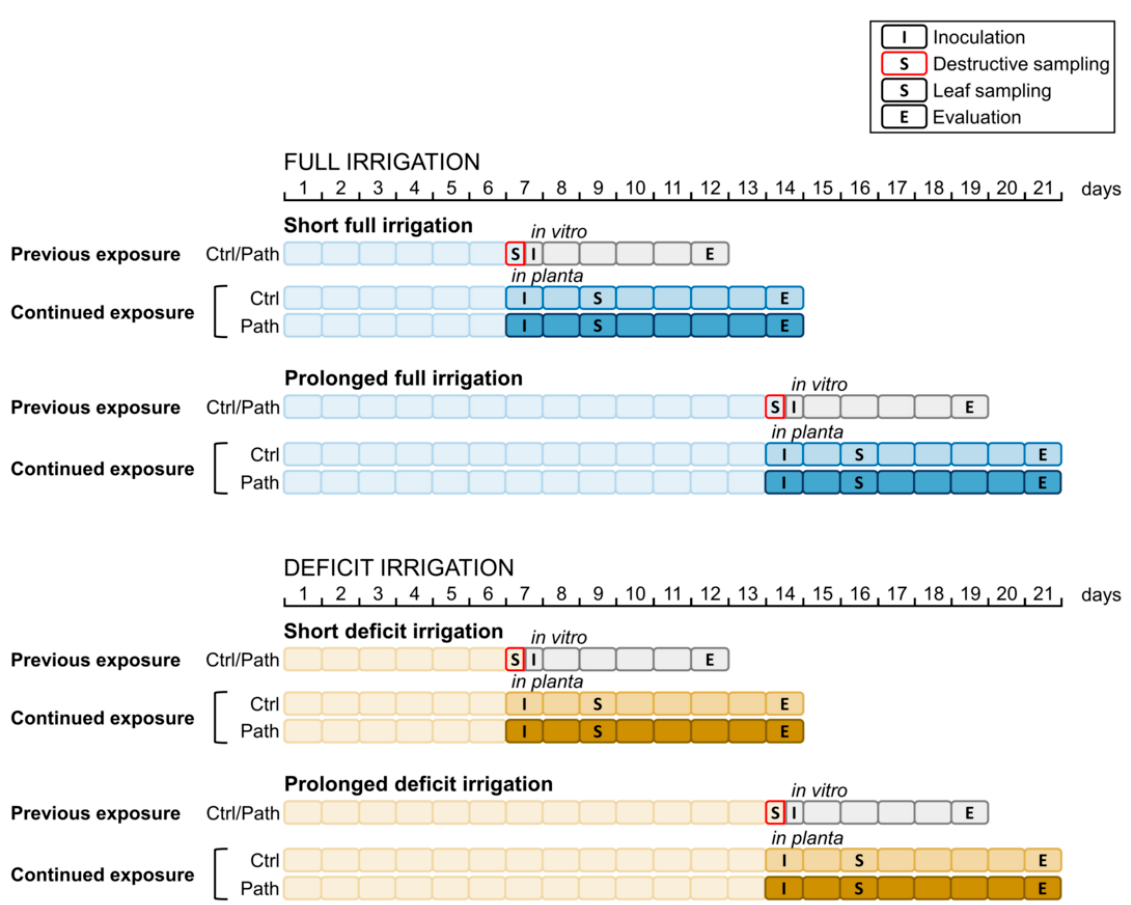
Figure 1. The 12 treatments used in this experimental setup. Each treatment group, represented by one timeline, consisted of five plants of both cultivars: drought-resistant Xynisteri and drought-sensitive Chardonnay. The plants were first exposed to 7 days of full/deficit irrigation (short full irrigation/short deficit irrigation) to establish the effect of short-term drought stress or to 14 days of full/deficit irrigation (prolonged full irrigation/prolonged deficit irrigation) to examine the effect of prolonged drought stress. At day 7 or 14, the plants were either sampled destructively or were maintained under the current irrigation regimen. Some of the sampled leaves of the first group were used for in vitro inoculation with water (Ctrl) or Plasmopara viticola (Path) to assess the effect of previous exposure to drought stress on disease development at 5 days post inoculation (dpi). The other groups were inoculated in planta, either with water (Ctrl) or with P. viticola (Path), to determine the effect of continued exposure to drought stress on disease development. These plants were maintained under full/deficit irrigation until disease evaluation at 7 dpi. From these plants, leaf samples were taken at 9 or 16 days of irrigation treatment (dot), corresponding to 1.5 dpi.